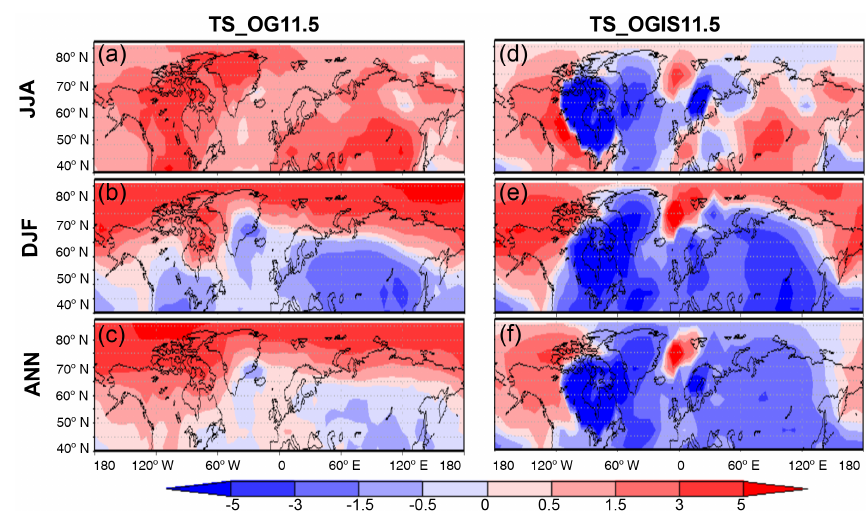
Figure 3. Simulated temperatures for 11.5kyr, shown as deviation from the PI. Left column shows the simulation with only GHG and ORB forcings (OG11.5). For the right column, the ice-sheet forcing is included (OGIS11.5). Upper, middle and lower panels present summer (JJA), winter (DJF) and annual mean temperatures,